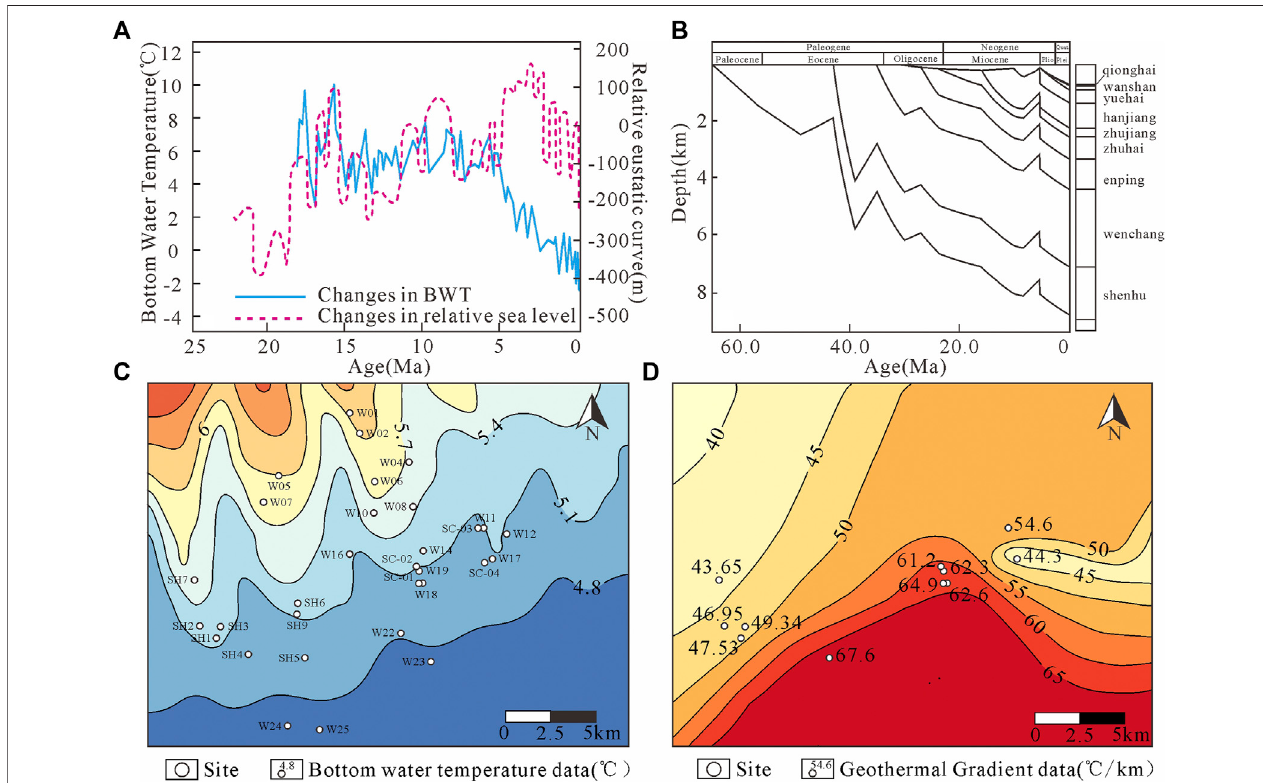
FIGURE 2 | (A) Changes in relative sea level and BWT at ODP 806 in the Pearl River Mouth Basin in the northern SCS (modi fi ed from Pang et al., 2007 and Lear et al., 2015); (B) Burial history of a single well in the Shenhu area, northern SCS; (C) The BWT characteristics in the Shenhu area, northern SCS; (D) The geothermal